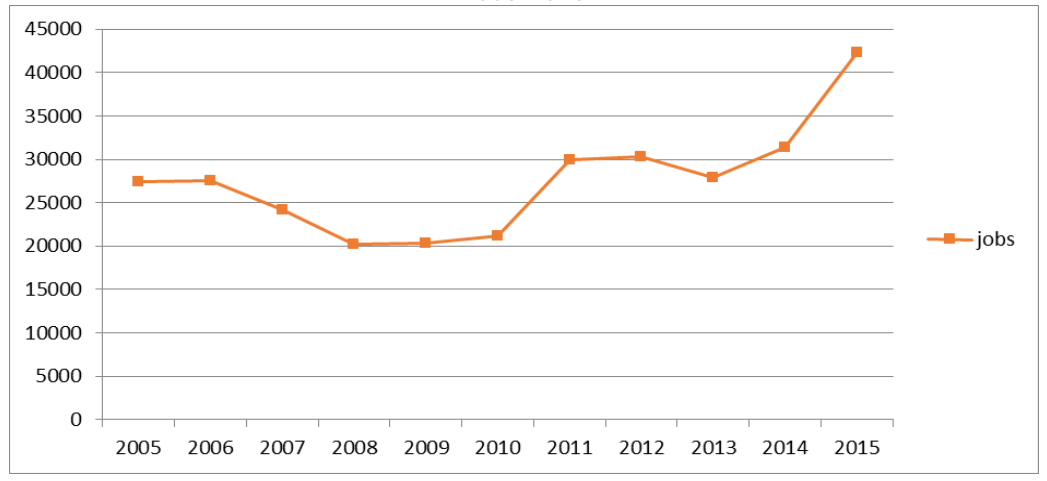
Figure 2: The evolution of the number of new jobs from FDI inward projects in the UK over